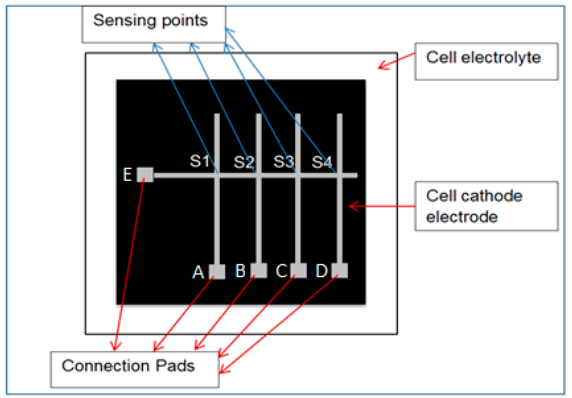
Figure 1. Schematic view of sputter-deposited 500 nm thick sensor thin film thermocouple array architecture.